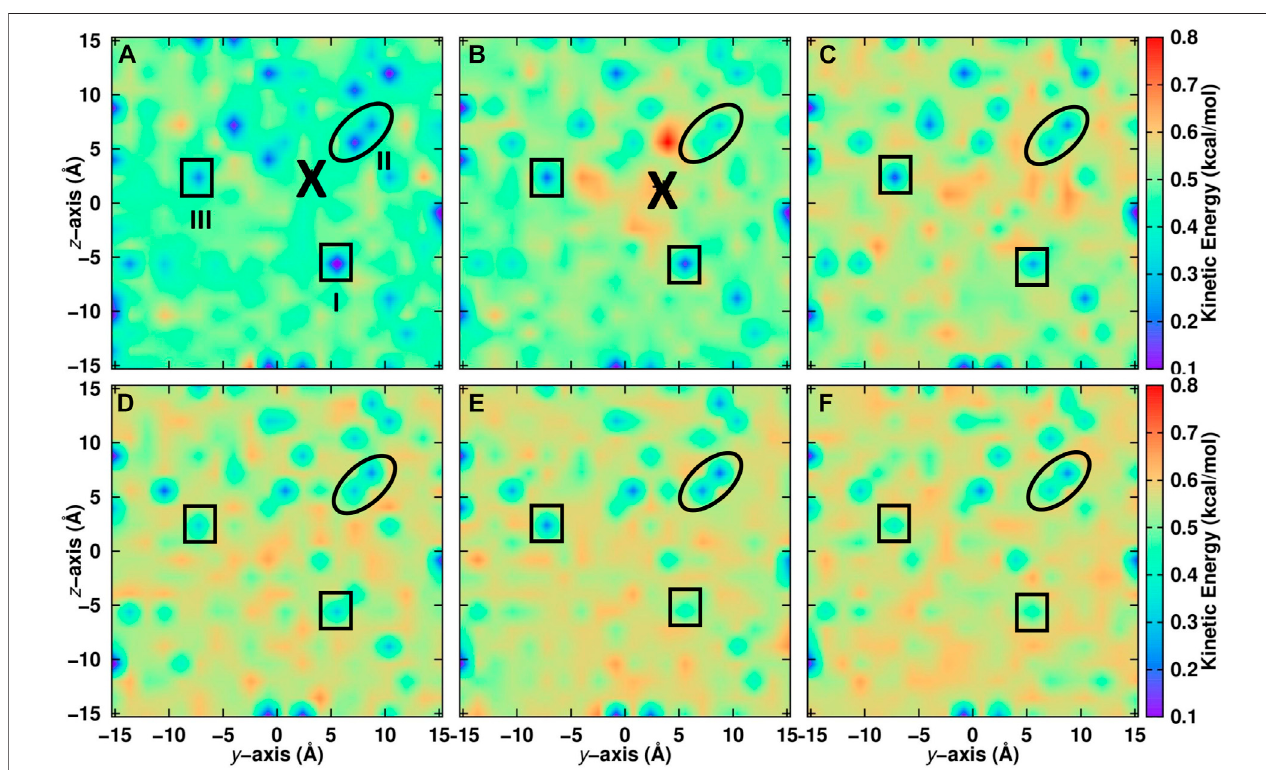
FIGURE 5 | Kinetic energy of water molecules projected onto the ( y , z ) − plane averaged over seven independent simulations on the top layer of the ASW surface. Recombination of CO and O takes place at the location labelled with “ X ” . Before recombination (A) : − 5 ≤ t ≤ 0 ps) and after recombination (B) : 0 ≤ t ≤ 5 ps, (C) : 5 ≤ t ≤ 10 ps, (D) : 10 ≤ t ≤ 50 ps, (E) : 50 ≤ t ≤ 100 ps and (F) : 100 ≤ t ≤ 200 ps). The average position of CO is indicated by a large black cross. Noteworthy regions are labelledItoIIIandsurroundedbysolidlines.RegionIiscoolatearlytimesandgraduallywarmsup.RegionIIremainscoolformostofthesimulationtimeandregion III alternates between cool and warm. For results within 10 Å of the surface, see Supplementary Figure S4